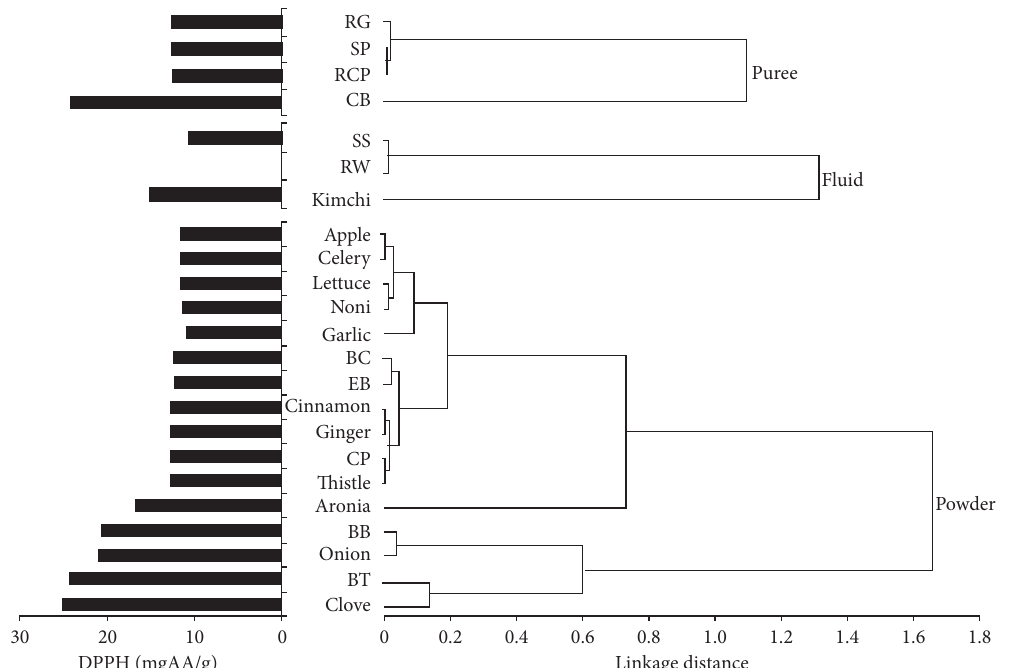
Figure 1: Dendrogram for variables from the hierarchical cluster analysis and 2, 2-diphenyl-1-picrylhydrazyl (DPPH) radical scavenging ability of natural plant sources. SS, soy sauce; RW, red wine; RCP, red chili paste; SP, soybean paste; RG, red ginseng; BC, blackcurrant; EB, elderberries; CP, chili pepper; BB, blueberries; CB, cherry berry; BT, black tea. Table 2: Antioxidant abilities of natural sources in pork patties after 10 days of cold storage. Treatments